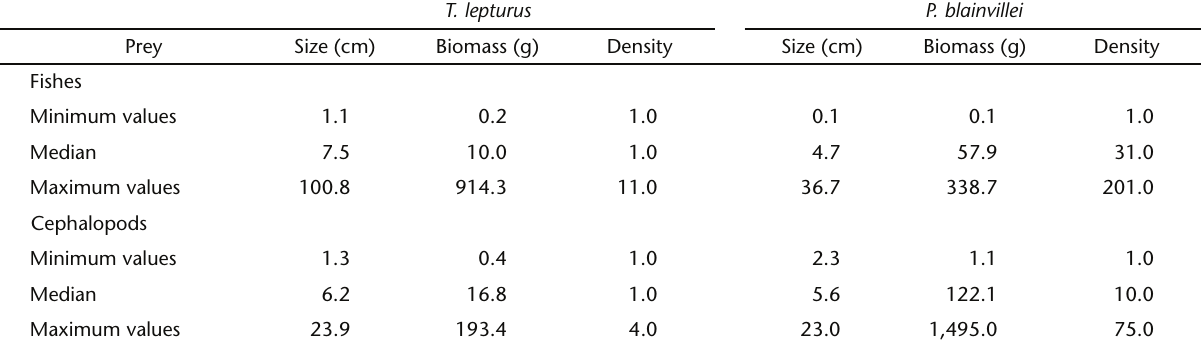
Table II. Size, biomass and density (number of individuals) of fishes and cephalopods consumed by T. lepturus and P. blainvillei in northern Rio de Janeiro. Total biomass and density (number of individuals) per stomach.